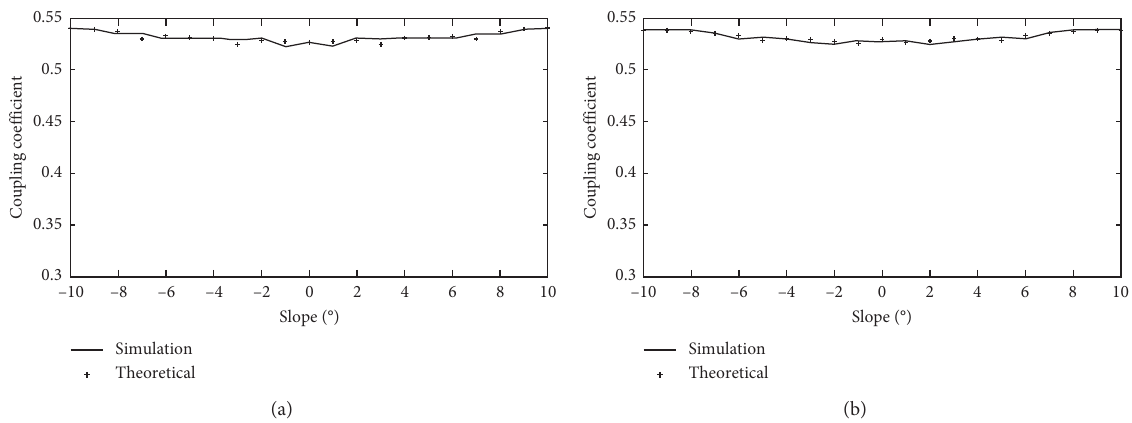
Figure 10: Coupling coefficient of secondary coil inclination angle less than 30mm. (a) Tilt in the Y direction. (b) Tilt in the X direction.